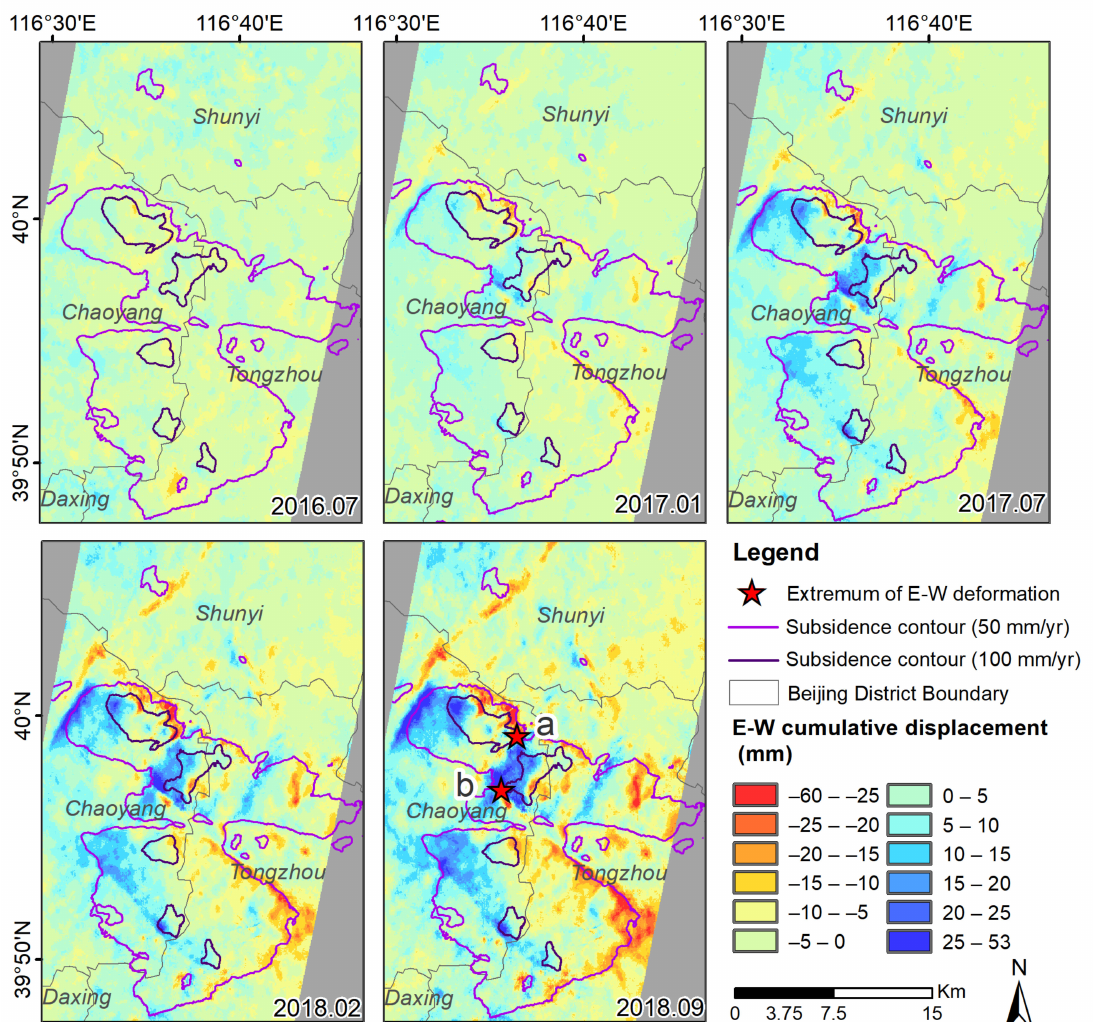
Figure 10. Time series maps of the east–west cumulative displacement. (a: Extremum of west horizontal displacement; b: Extremum of east horizontal